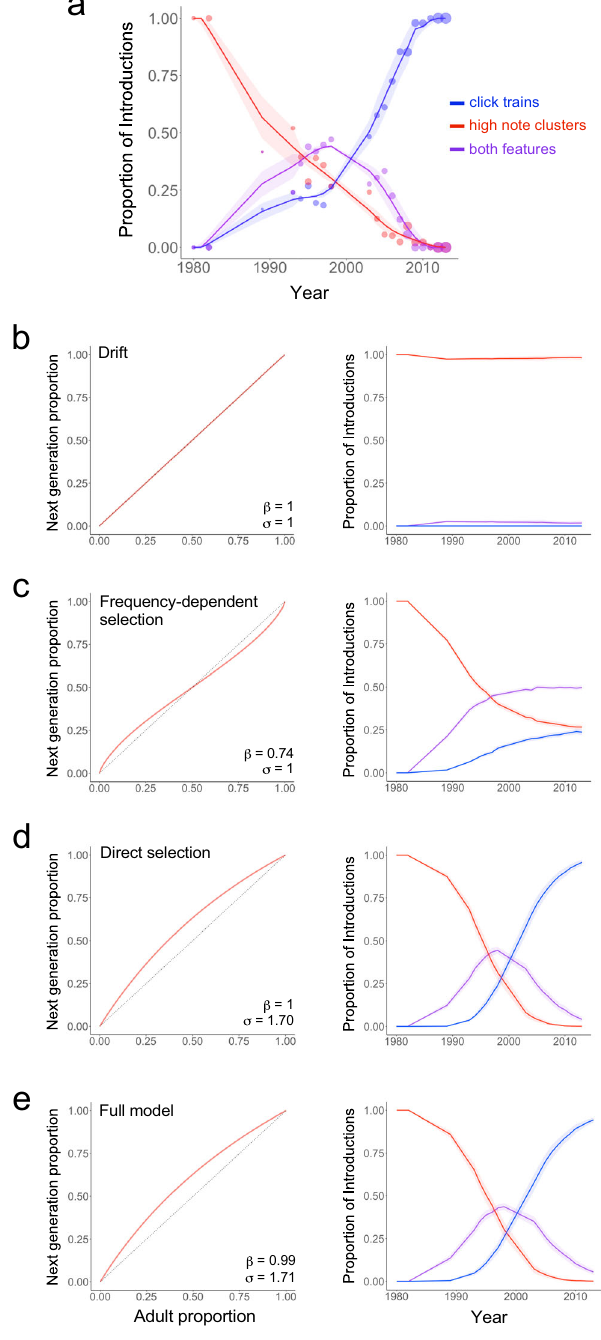
Fig. 4 Modeling replacement of high note clusters by click trains. a Historical data showing proportions of songs with high note clusters (red), both high note clusters and click trains (purple), and click trains alone (blue). Point sizes are proportional to numbers of songs recorded in a given year, solid lines are splines fi tted to each category, and shading represents the 95% con fi dence interval. b – e The learning curves (left) and outputs of model (right, with 95% con fi dence interval error bands) and the frequency- dependent bias and/or selection parameters that generated the best fi t to the historical data for each type of model. b Cultural drift model. c Best- fi tting frequency-dependent learning bias model ( β = 0.74 represents a moderate rare-form bias). d Best- fi tting selection model ( σ = 1.70 represents moderate to strong selection for click trains). e Best- fi tting full model that simultaneously varied selection and frequency-dependent bias. The best version of this model is nearly identical to ( d ) with essentially no frequency-dependent bias ( β = 0.99 ≈ 1.0 = no frequency-dependent learning) and moderate to strong selection ( σ = 1.71). Source data are provided in the Source Data fi